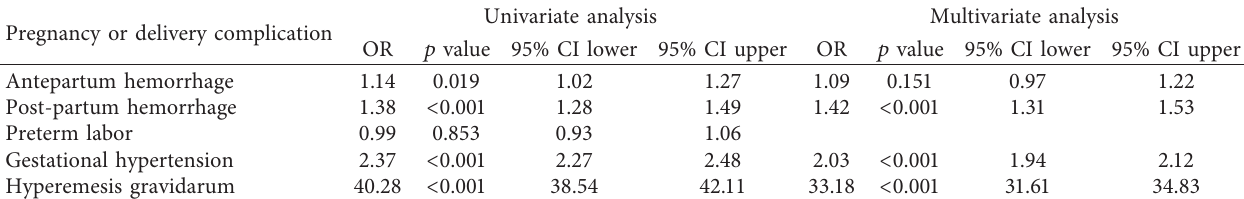
Table 5: Obstetric complications and the risk of pregnancy-related